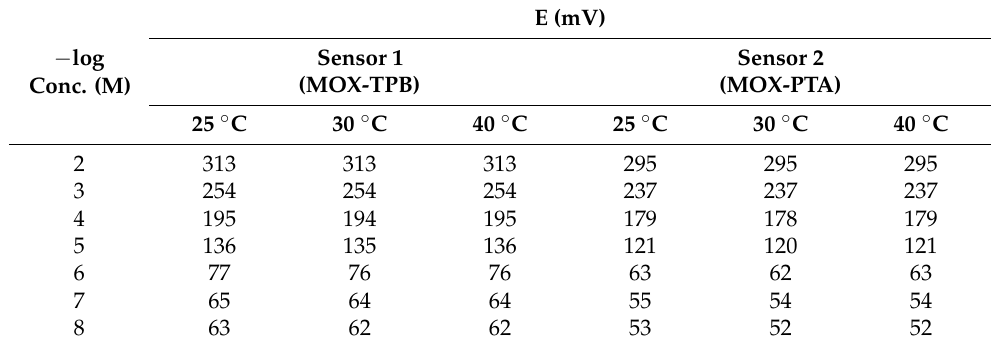
Table 2. Profile of the potential versus –log concentration for the fabricated sensors at three tempera- tures (25 ◦ C, 30 ◦ C, and 40 ◦